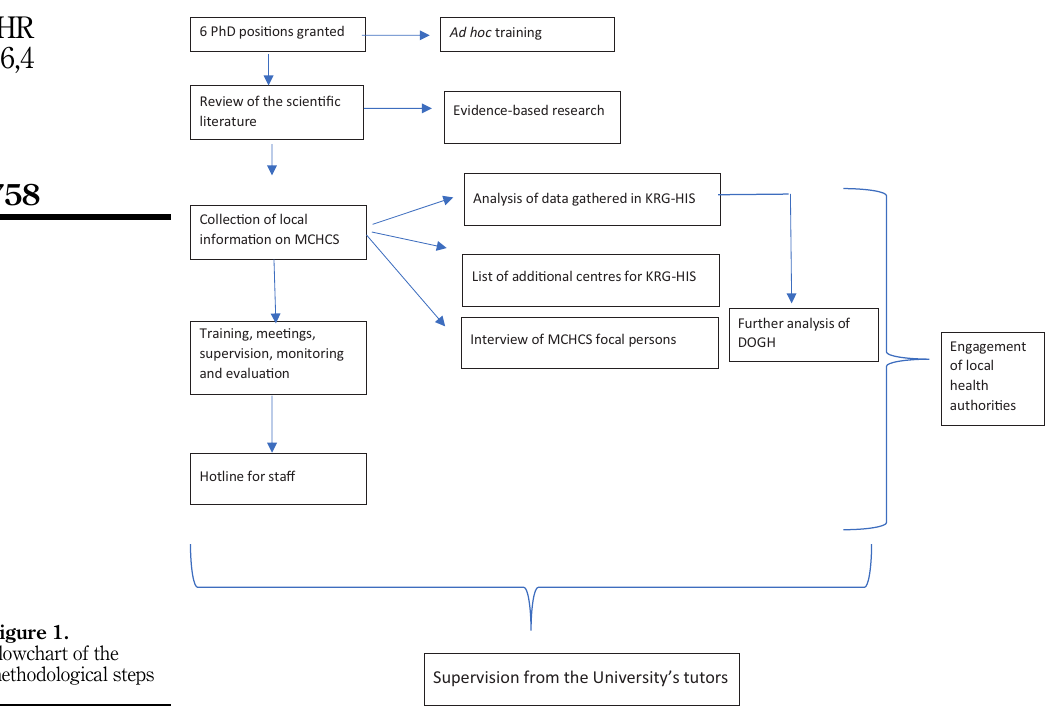
Figure 1. Flowchart of